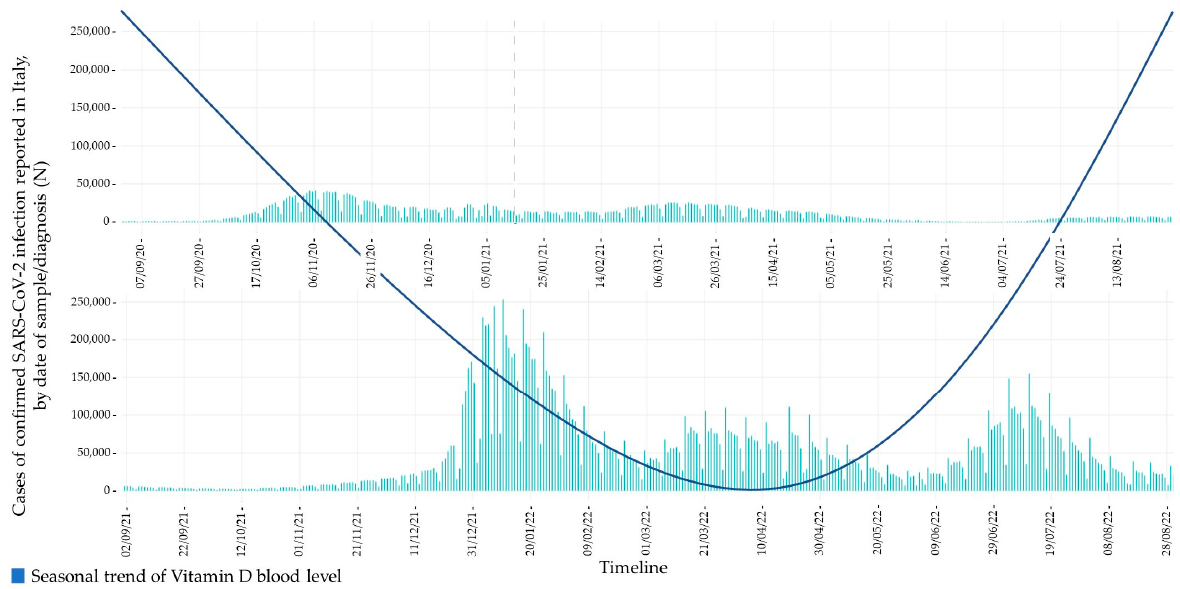
Figure 1. Hypothesised U-shaped relationship between protective serum concentration of vitamin D in the cold season and the risk of the SARS-CoV-2 infection. Modified from: The COVID-19 Task force of the Department of Infectious Diseases and the IT Service, Istituto Superiore di Sanità. COVID-19 integrated surveillance data in Italy. Available online: h tt ps://www.epicen- tro.iss.it/en/coronavirus/sars-cov-2-dashboard (accessed on 01 March 2023).